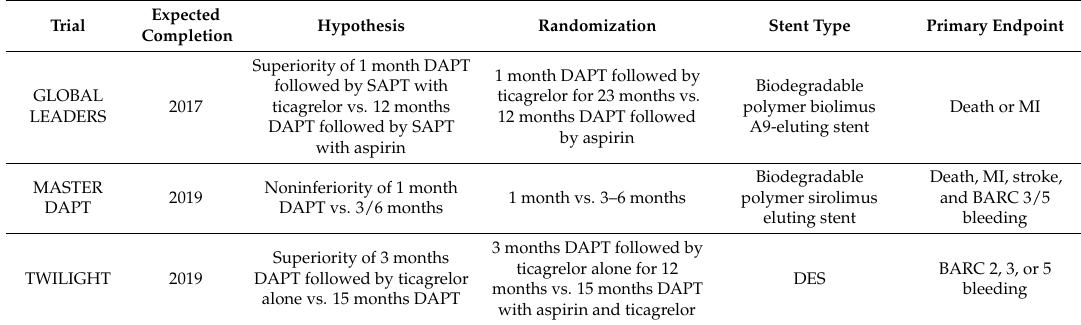
Table 10. Comparative features of prominent future randomized controlled trials evaluating novel DAPT